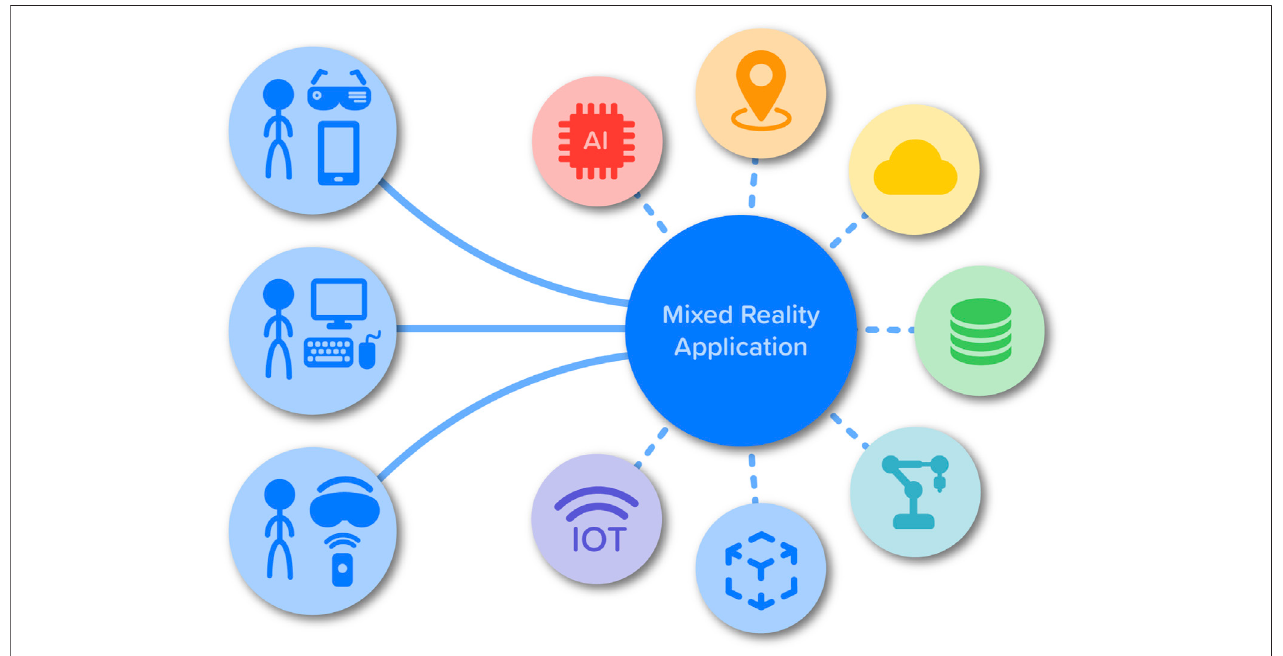
FIGURE2| OverviewofsystemsthatmightplayaroleinMRapplicationsandtheircombinedpotential(AI,location,cloud,databases,robotics,virtualmodels,IoT). EachcircletypicallyrepresentsadistinctsystemwithitsownAPI.Circlestotheleft(ARglasses+smartdevice,desktopPC,VRequipment)areexamplesoftechnologies used by humans to integrate with the rest of the virtual world (their “ digital skin ”